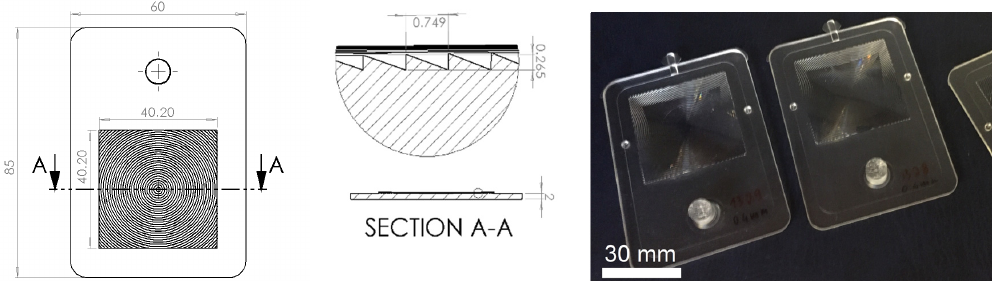
Figure 12. Design specification of the analyzed Fresnel lens ( left ) and detail of the low aspect ratio surface structures ( center ); injection molded parts ( right ) [33].